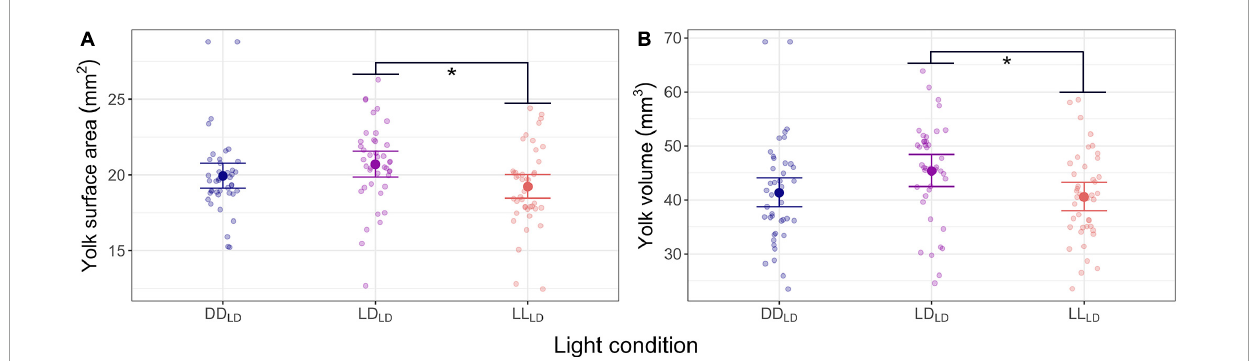
FIGURE3 Model predicted values and raw data of yolk sac in first feeding Atlantic salmon at 830 dd for the three light conditions (DD LD , LD LD , and LL LD ). (A) Yolk sac surface area (mm 2 ). (B) Yolk sac volume (mm 3 ). The larger dots and lines indicate model-predicted means and 95% confidence intervals, respectively, for each light condition group. Transparent dots represent individual raw data points. Per light condition groups n = 41, for DD LD and LD LD , and n = 42 for LL LD . Asterisks show the significant level (* indicates p <